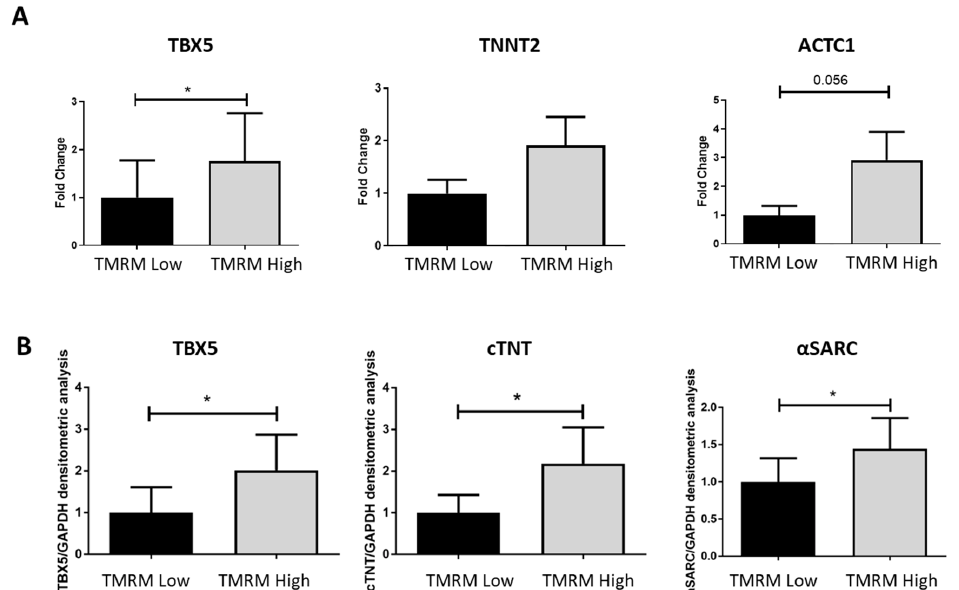
Figure 6 . In vitro endothelial differentiation in TMRM-low and high cells. ( A ) Cultrex assay: representative images of tubular-like structures formation in TMRM-low and TMRM-high cells on Cultrex membrane. The left panels show the quantification of tubular-like structures per microscopic field at 4 h and 20 h. The right panels show the number of branching points between tubular-like structures at 4 h and 20 h. In these conditions ( n = 6); ( B ) FACS analysis: bar graphs show the expression of VEGFR-2 / KDR, CD31, and vascular endothelial (VE)-cadherin / CD144 in TMRM-low and TMRM-high cells after culture into endothelial growing medium-2 (EGM-2) for 1 week. In these conditions ( n = 3); ( C ) gene expression: bar graphs show the expression of VEGFR-2 / KDR and NOS3 in TMRM-low, and TMRM-high cells after culture in EGM-2 for 1 week. Data are represented as mean ± SD of the fold change. Statistical di ff erences were calculated significant as * p < 0.05, determined by Student’s t -test.